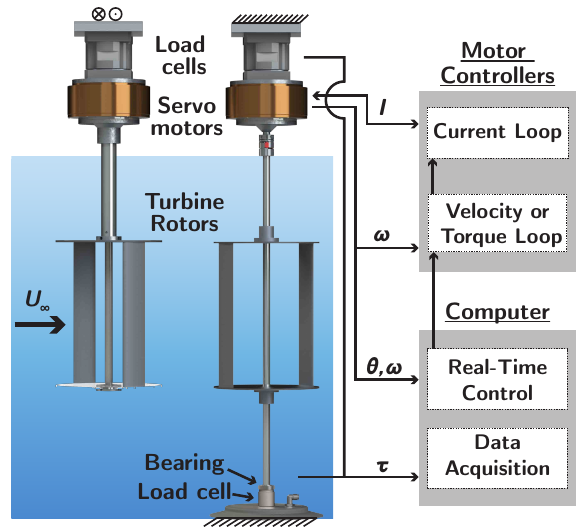
Fig. 2. Turbine test setups. The downstream setup is fixed and is used for single and dual turbine experiments. The upstream setup is used for dual turbine setups and is movable in the cross-stream wise direction via a robotic gantry. A computer with data acquisition cards and a real-time control kernel monitors and records encoder positions and turbine torques. Command signals are sent to motor controllers which operate the turbines under torque or velocity